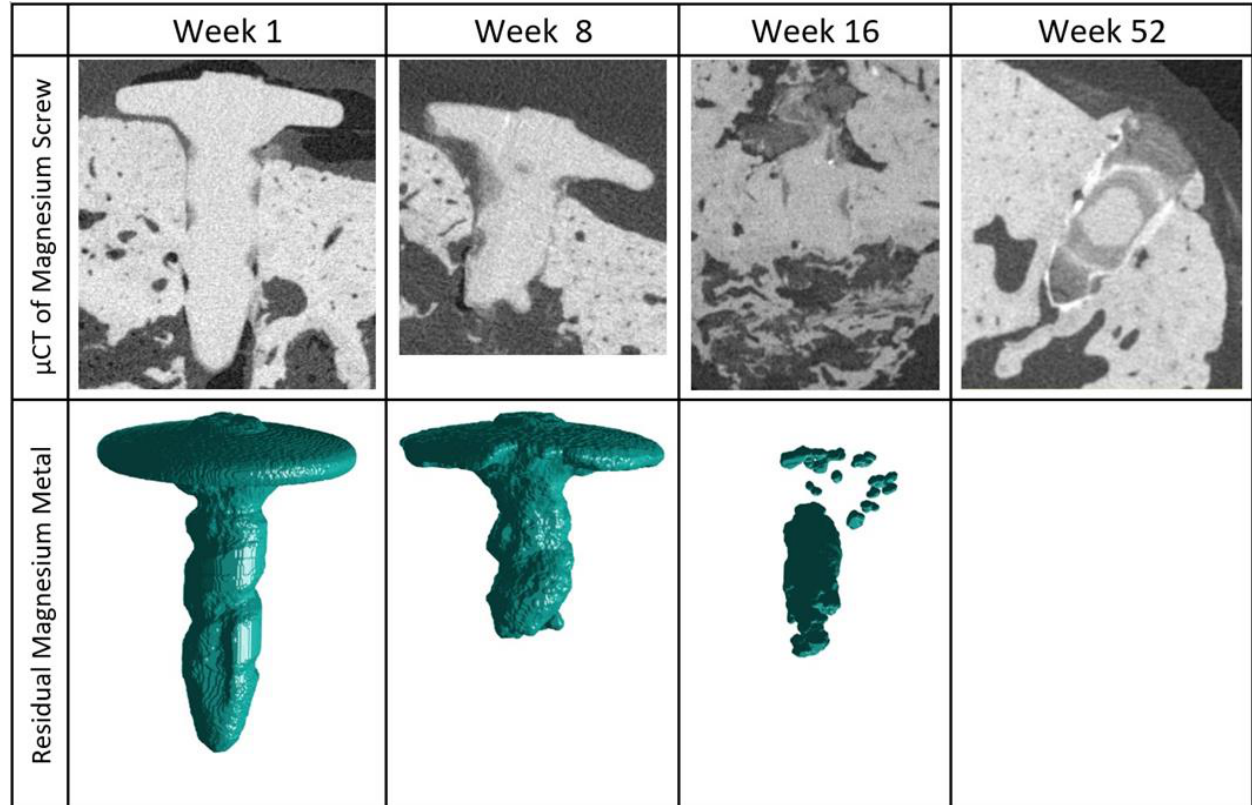
Figure 4. Reconstructed µCT images showing the residual metallic magnesium. The 3D structure of the remaining magnesium metal has been extracted from the µCT data and presented for each timepoint. Due to the small size and few samples with remaining magnesium metal (3 samples with remnants out of 16 samples) at the 52-week timepoint, the residual 3D metallic structure of the screw could not be recreated. Mineralized magnesium degradation products can be seen retaining a partial shape of the degraded fixation screw. The metallic volume and surface area of the screws were measured at each timepoint, the results of which are shown in Figure 5. At 1 week, the mean total volume of the mag- nesium screw was 3.43 ± 0.15 mm 3 ; at 8 weeks it was 2.35 ± 0.45 mm 3 ; and at 16 weeks it was 1.23 ± 0.69 mm 3 . At the 52-week timepoint, the mean total volume of the magnesium screws showed an almost complete degradation and was measured at 0.03 ± 0.06 mm 3 . The corresponding surface area of the screw remnants was 17.49 ± 0.46 mm 2 , 14.76 ± 1.31 mm 2 , 10.31 ± 3.49 mm 2 , and 0.34 ± 0.72 mm 2 at 1, 8, 16, and 52 weeks, respectively.